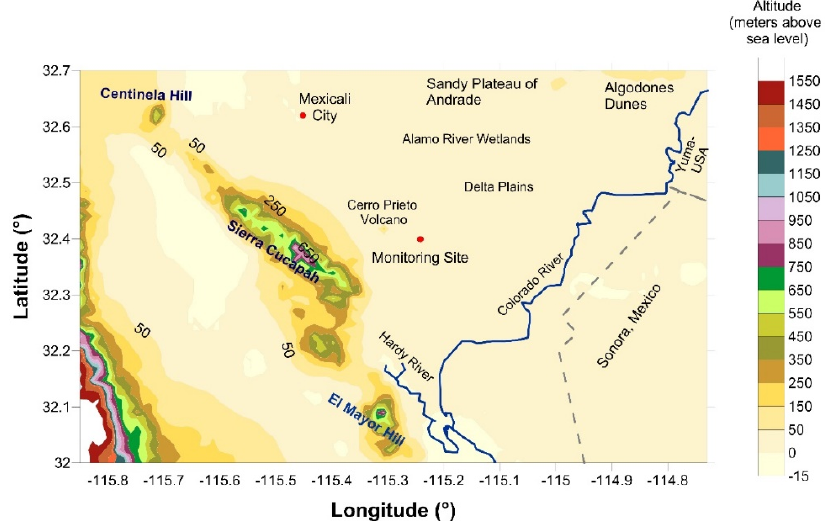
Figure 1. The Mexicali Valley. Monitoring site and its surroundings. Altitude scale in meters.